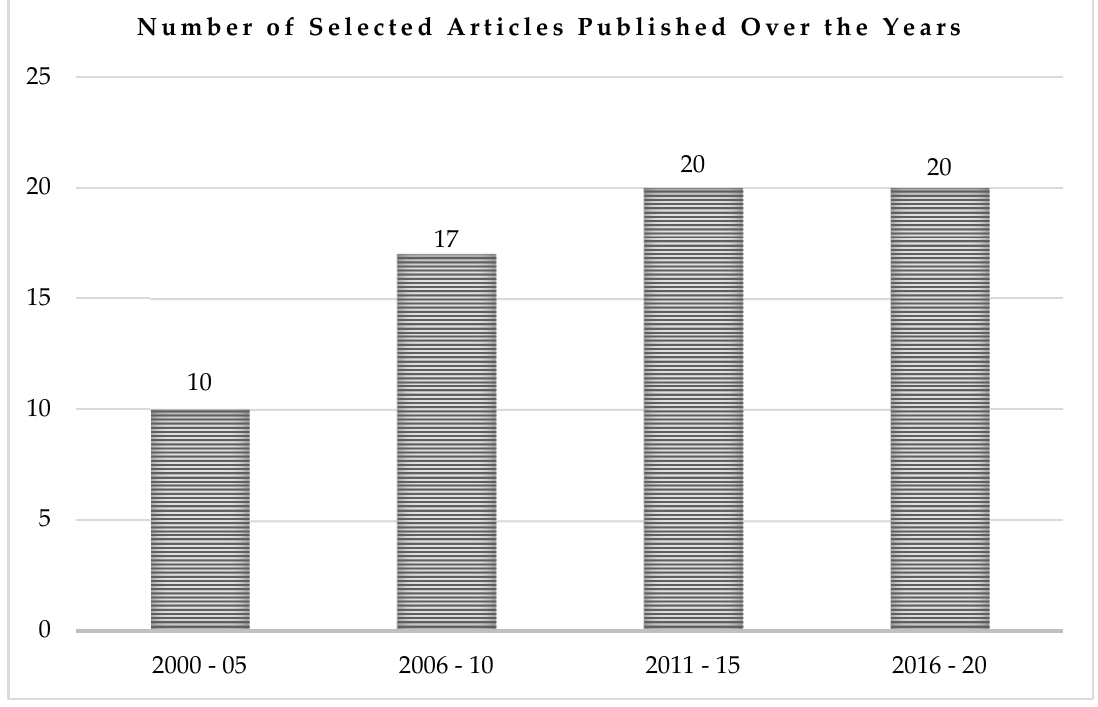
Figure 2. Distribution of Selected Articles between 2000 and 2021 (No article from 2021 was selected), Source: The Authors.